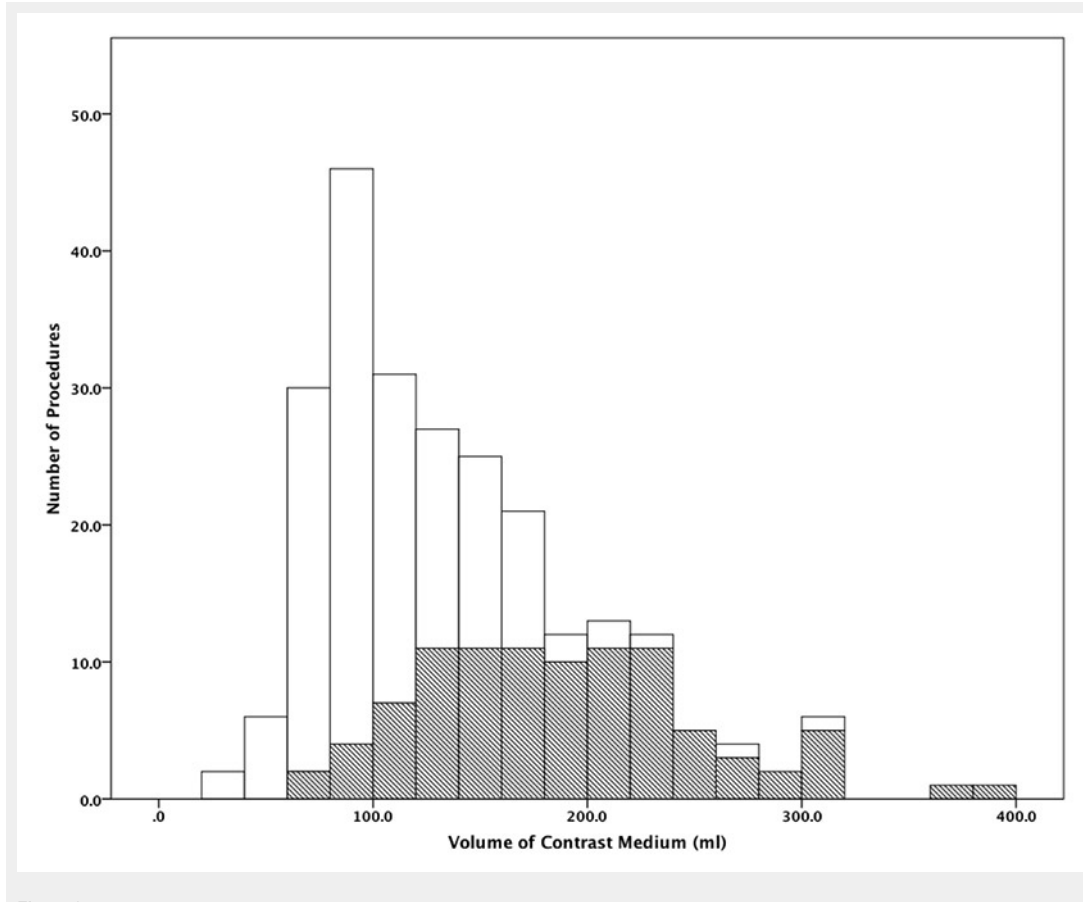
Figure 2 Distribution of the volume of contrast medium used for diagnostic (white areas) and for therapeutic (dashed areas) percutaneous coronary